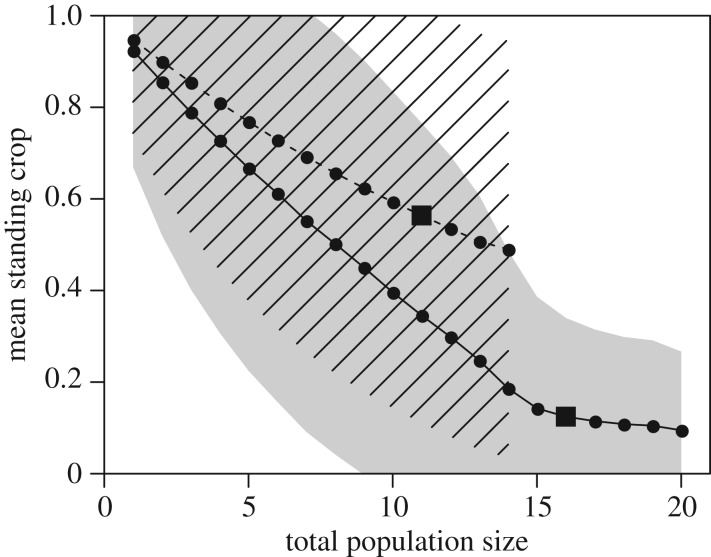
Mean±s.d. standing crop in the patches (expressed as a fraction of the maximum patch resource capacity Qmax) at the end of each time window, as a function of the total population size, for populations of memoryless (dashed line and zebra area) versus with-memory individuals (plain line and grey area). The variation shown is the mean standard deviation between patches within simulations. The squares represent the mean standing crop at the carrying capacity for both types of populations.